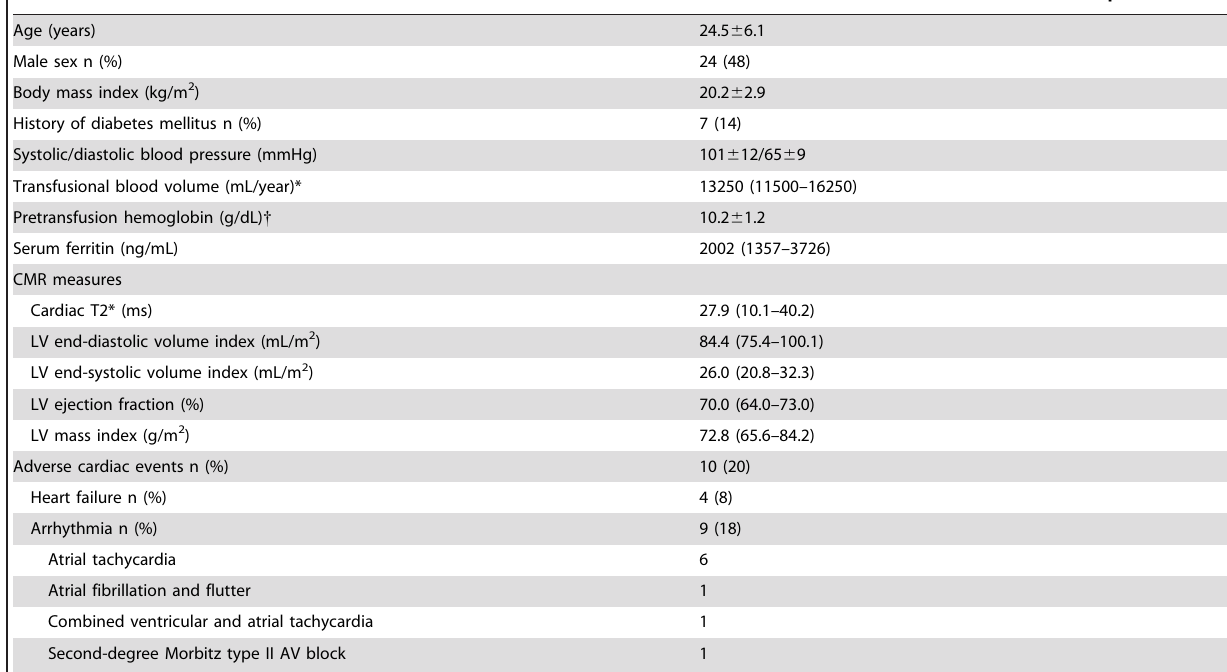
Table 1. Patient characteristics.